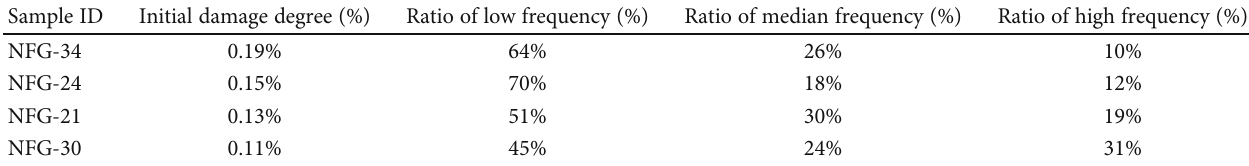
Table 3: Percentage of the low, medium, and high frequency AE signals during rock deformation for the typical samples. Sample